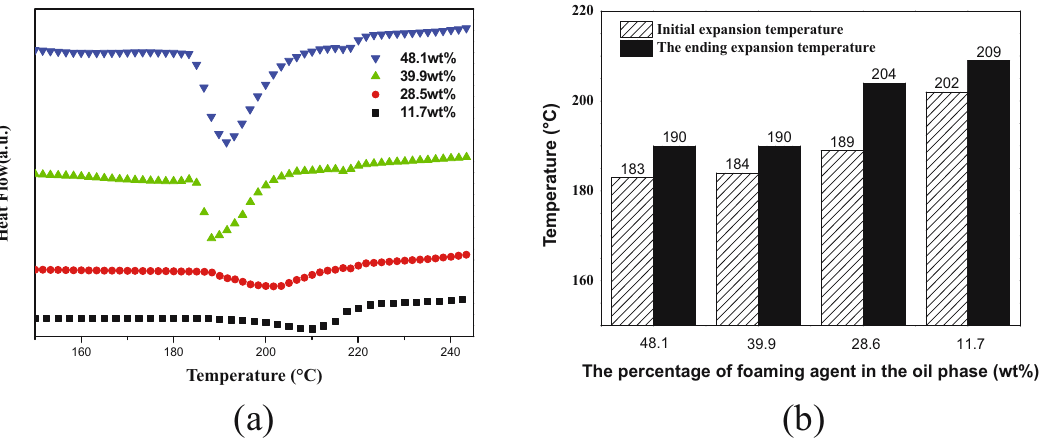
Figure 1: E ff ect of microsphere expansion temperature under di ff erent content of foaming agent: ( a ) DSC curve and ( b ) expansion temperature.